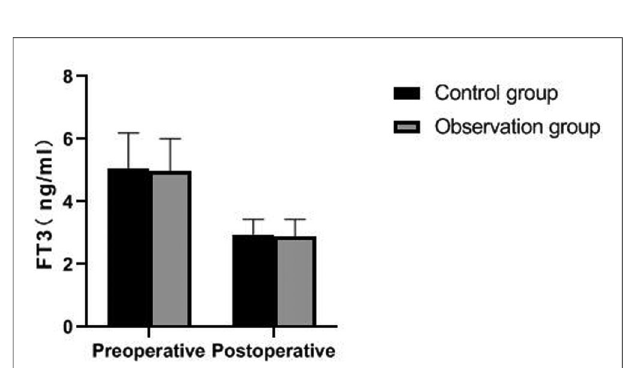
FIGURE 5 | Comparison of FT3 levels between the two groups.